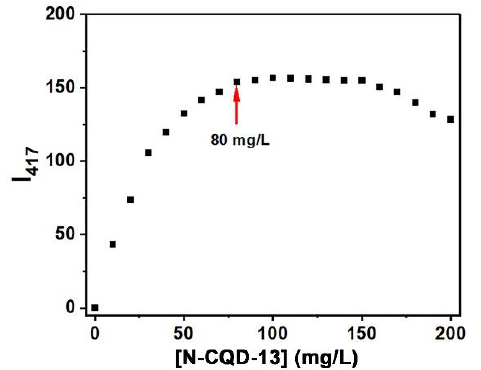
Figure 6. Emission intensities at 417 nm of N-CQD-13 solutions in different concentrations (0 – 200